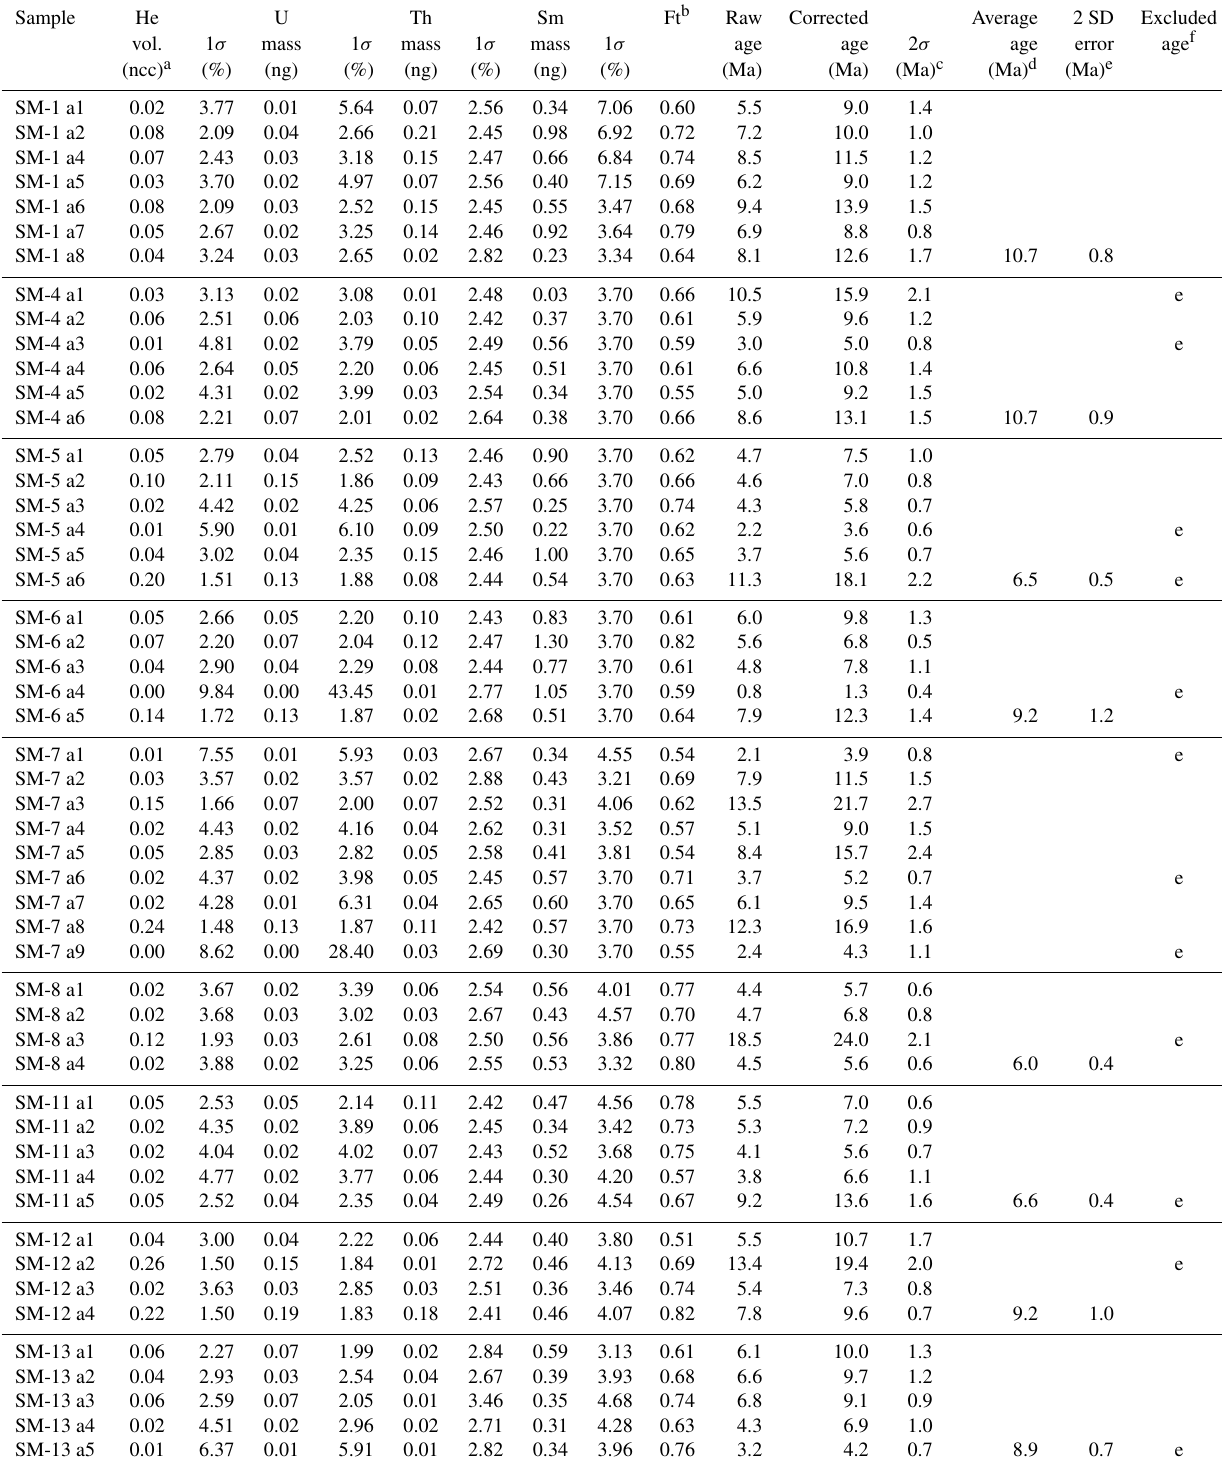
Table 1. Apatite ( U − Th − Sm )/ He dating results.